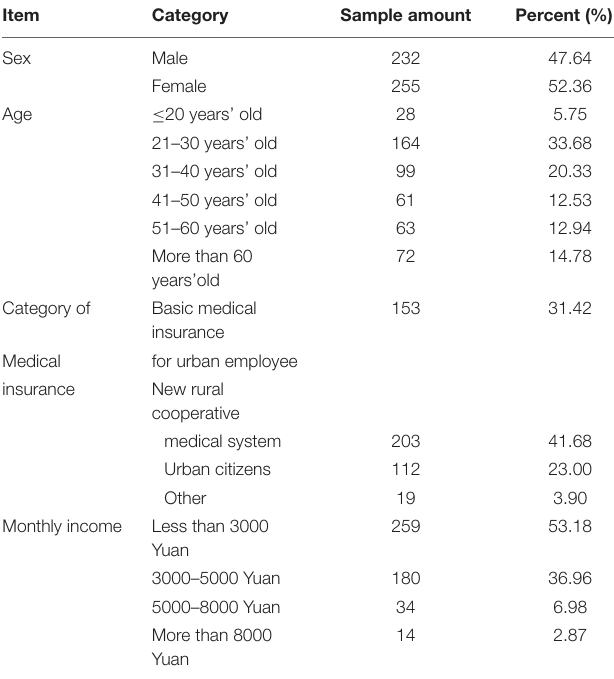
TABLE 1 | Distribution of the survey